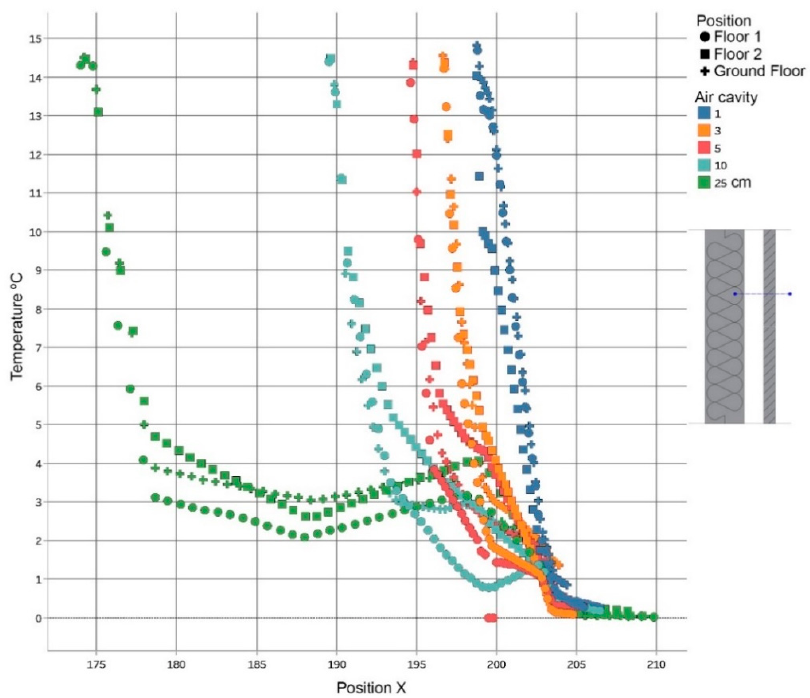
Figure 6. Temperatures in the air chamber, according to the floor and the size of the chamber.